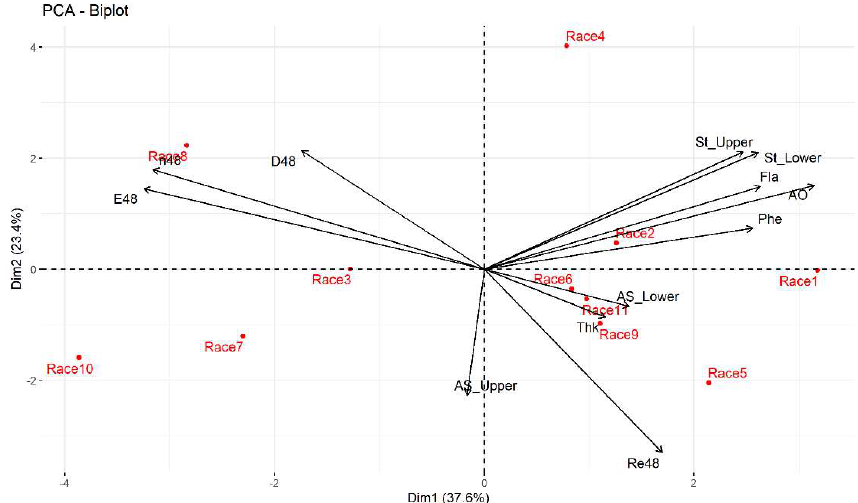
Figure 4. Biplot of the first two principal components of the thirteen variables and 11 maize races at 48 h under laboratory conditions. Race 1—Raton; Race 2—Olotillo; Race 3—Tuxpeño Norteño; Race 4—Bolita × Raton; Race 5—Elotes Occidentales × Tuxpeño; Race 6—Tabloncillo × Tuxpeño;